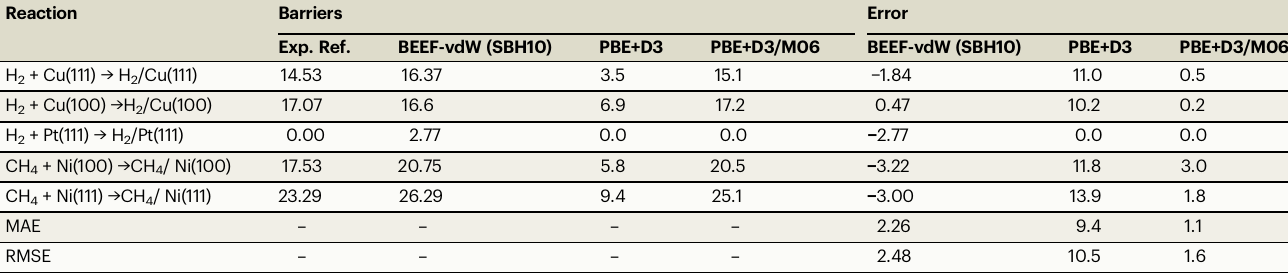
Table 4 | Experimental and calculated reaction barriers (kcal mol − 1 ) and associated errors Reaction Barriers Error Exp. Ref.